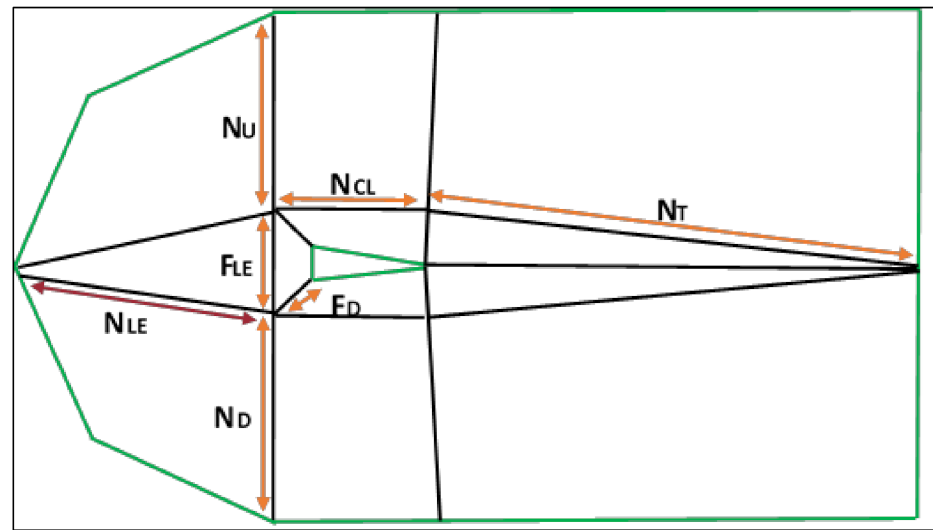
Figure 8. Meshing design topology and its naming.